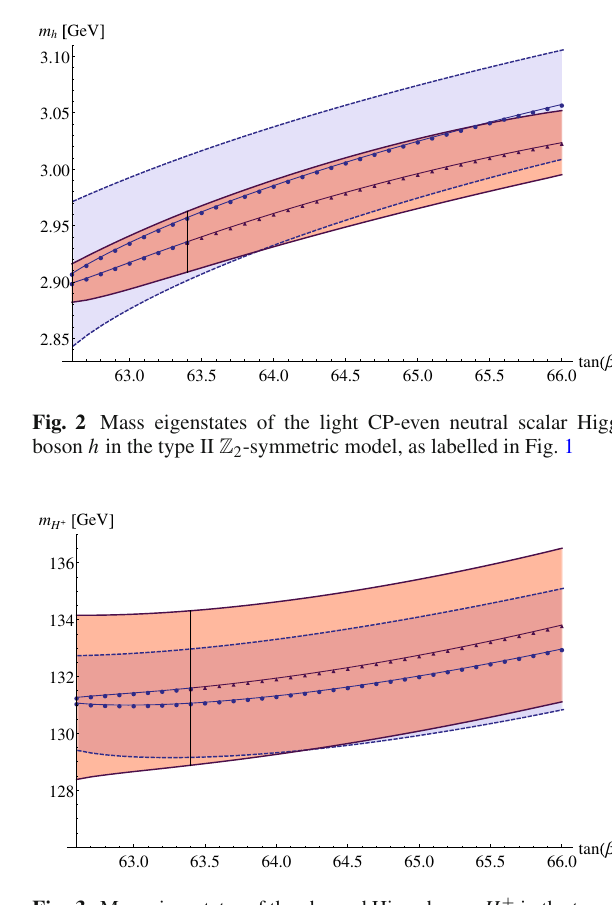
Fig. 3 Mass eigenstates of the charged Higgs boson H + in the type II Z 2 -symmetric model, as labelled in Fig.